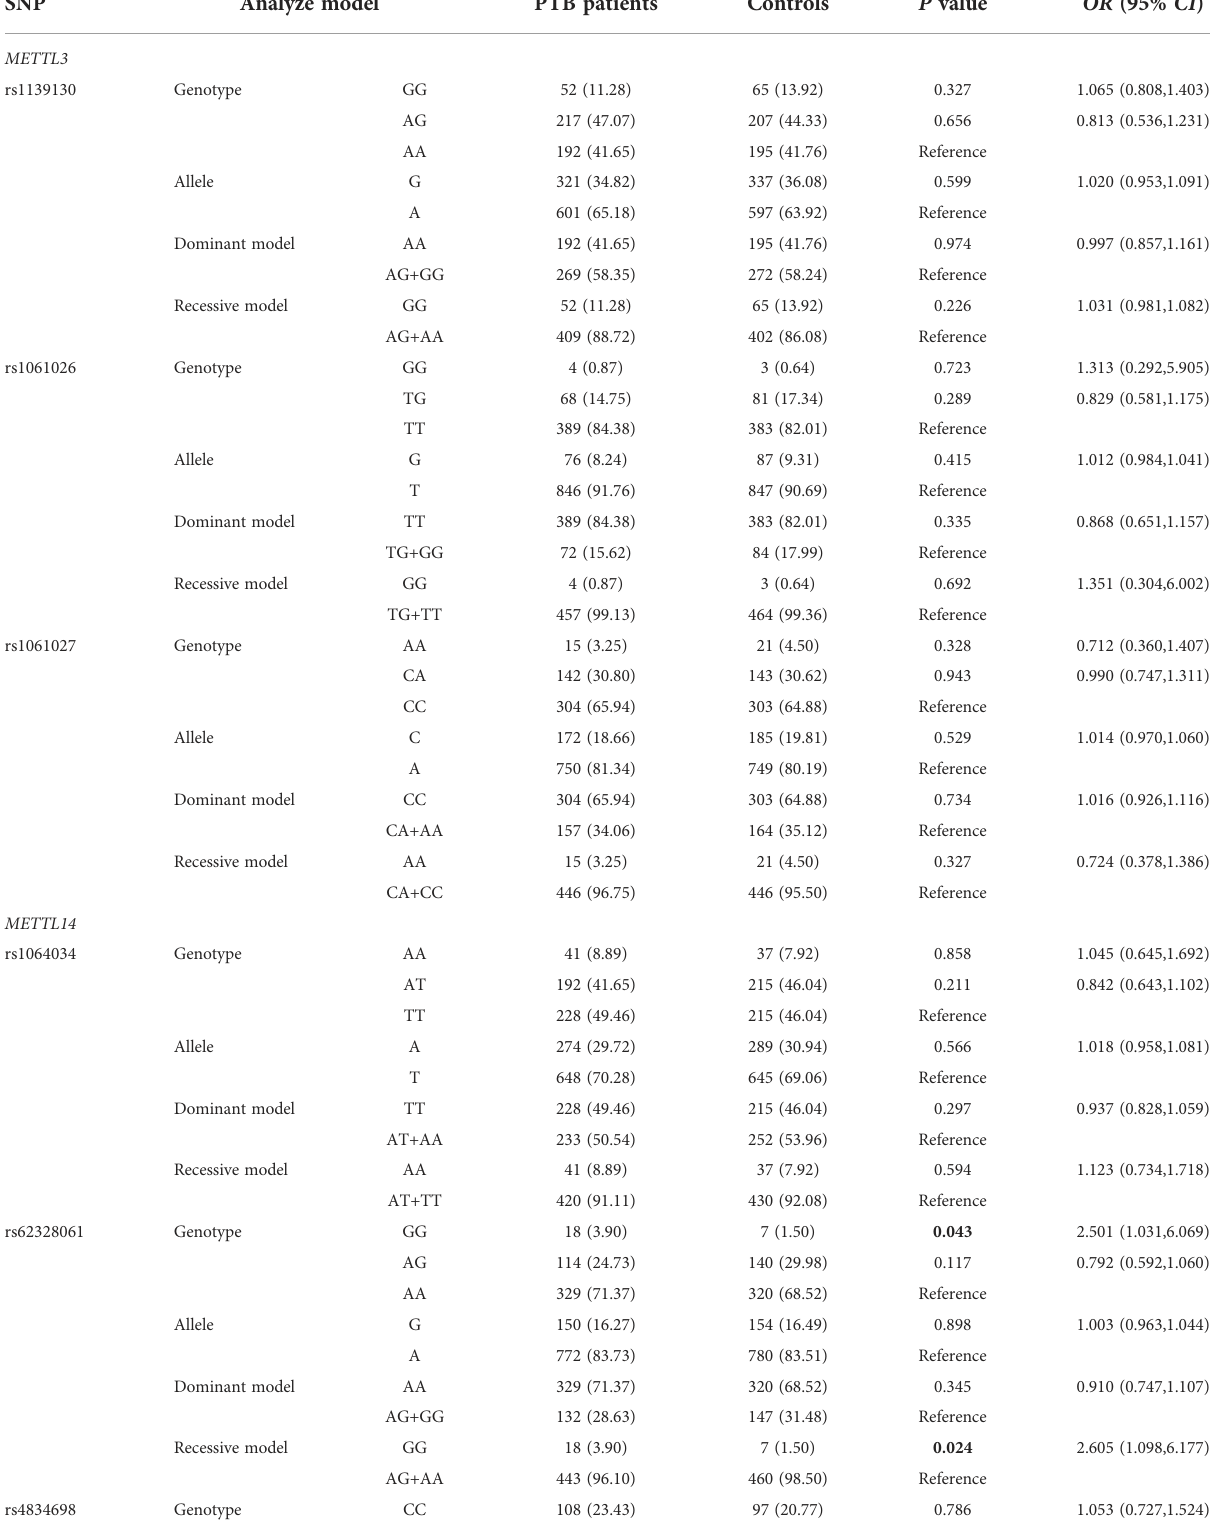
TABLE 1 Association between METTL3 , METTL14 , and WTAP genes polymorphism and PTB